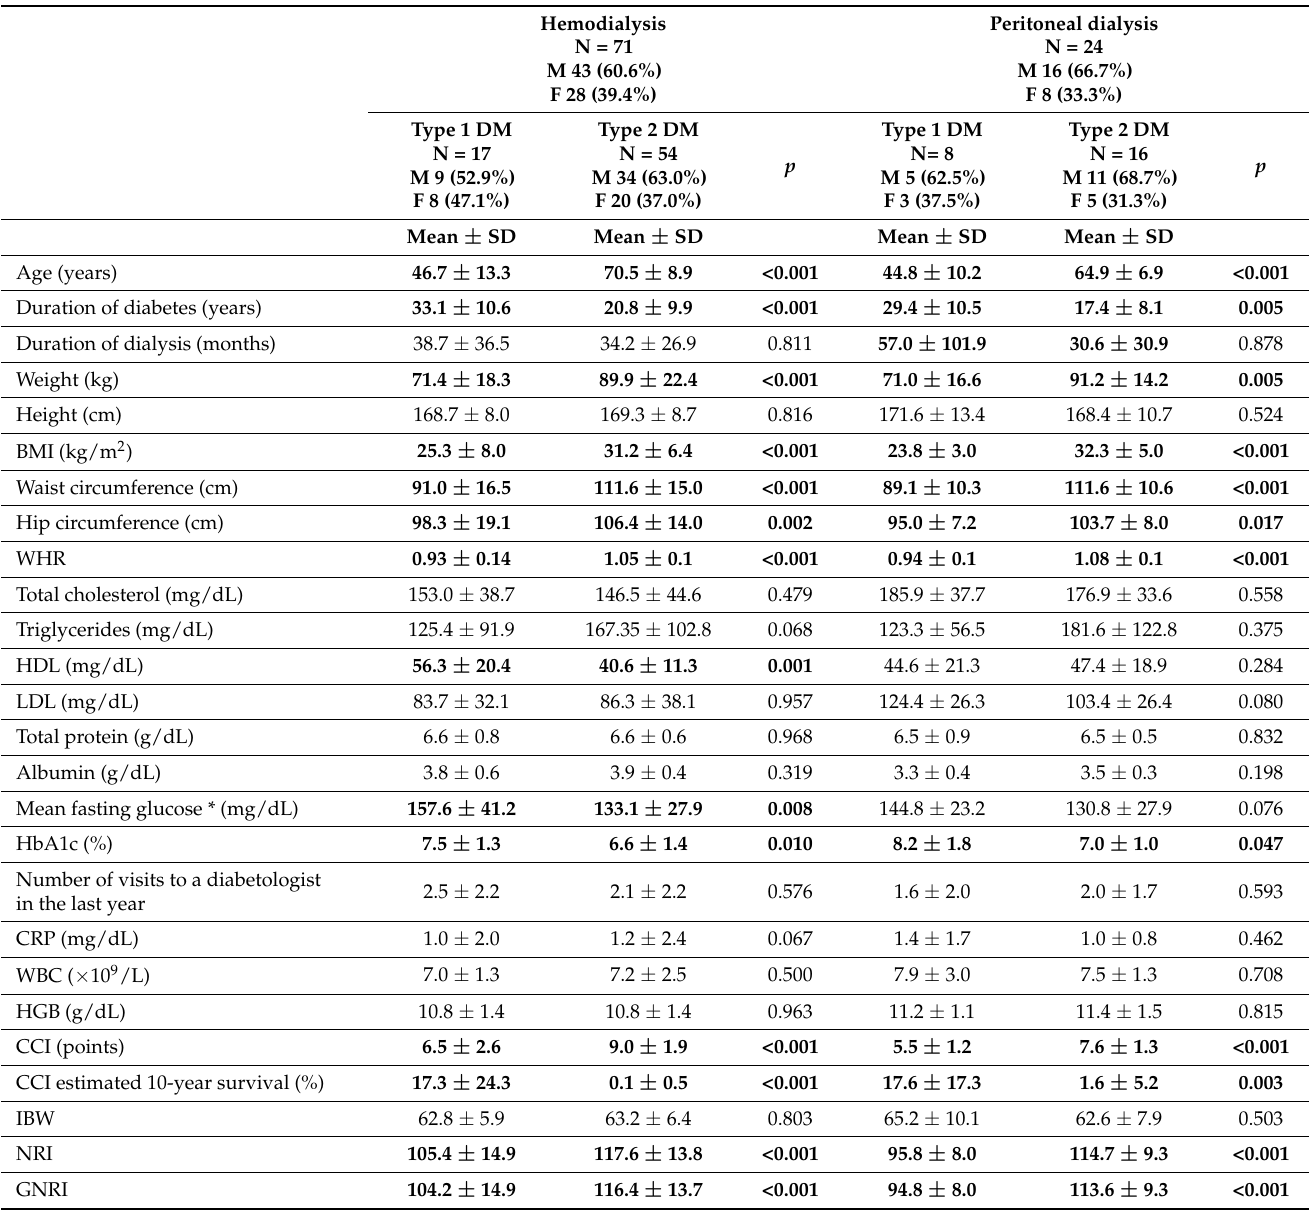
Table 1. Characteristics of the hemodialysis and peritoneal dialysis patients, grouped according to the type of